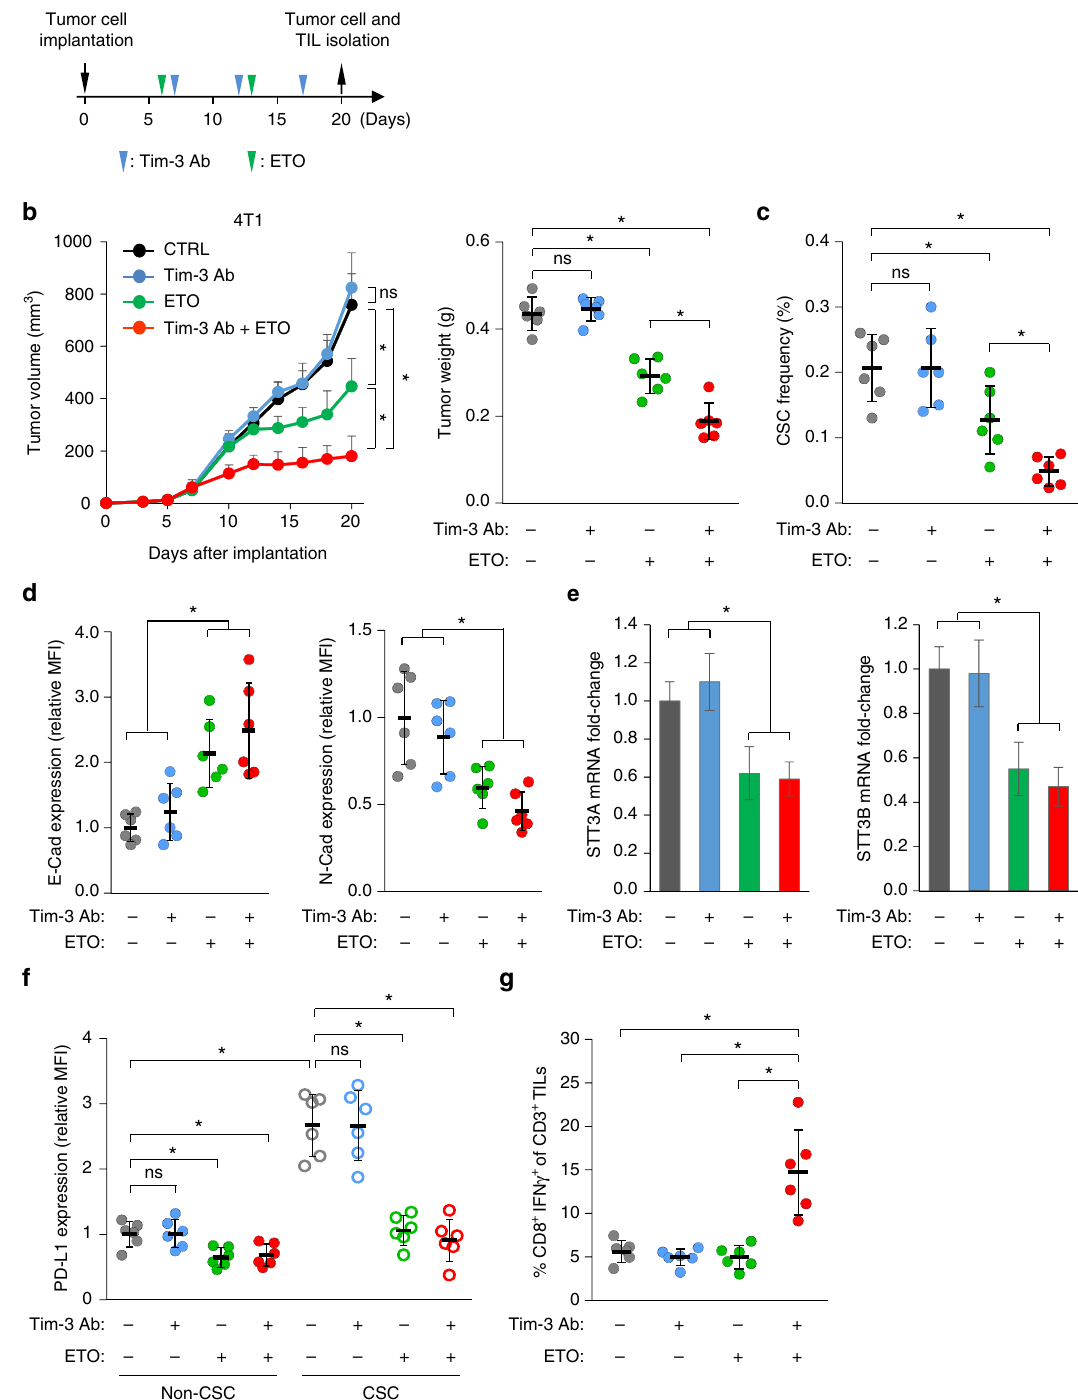
Fig. 7 Etoposide enhances the therapeutic ef fi cacy of Tim-3 blockade therapy. a Schematic diagram illustrating the treatment protocol of Tim-3 antibody (Tim-3 Ab) and/or etoposide (ETO) in mice. At the endpoint, tumor cells and tumor-in fi ltrating lymphocytes (TIL) were isolated for analysis. b Tumor growth of 4T1 cells in BALB/c mice treated with Tim-3 antibody and/or etoposide. Tumor size was measured at the indicated time points and tumor weight was measured at the endpoint ( n = 6 mice per group). c Ef fi cacy of indicated treatments on the CSC (CD44 + CD24 + ALDH1 + populations) frequency of 4T1 tumors. d Flow cytometric analysis analyzing the effect of indicated treatments on the expression of E-cadherin (E-Cad, epithelial marker) and N- cadherin (N-Cad, mesenchymal marker) in the entire cancer cell population of 4T1 tumors. e qRT-PCR analysis of the in fl uence of indicated treatments on STT3 isoforms expression in the entire cancer cell population of 4T1 tumors. f Effect of indicated treatments on PD-L1 expression in the CSC and non-CSC populations of 4T1 tumors. g Intracellular cytokine staining of CD8 + IFN γ + cells in the CD3 + T cell populations from isolated tumor-in fi ltrating lymphocytes to analyze the impacts of indicated treatments on tumor-in fi ltrating cytotoxic T cell activity. Error bars represent s.d. ( n = 6). * P < 0.05; ns: non-signi fi cant, Student ’ s t -test. See also Supplementary Fig.